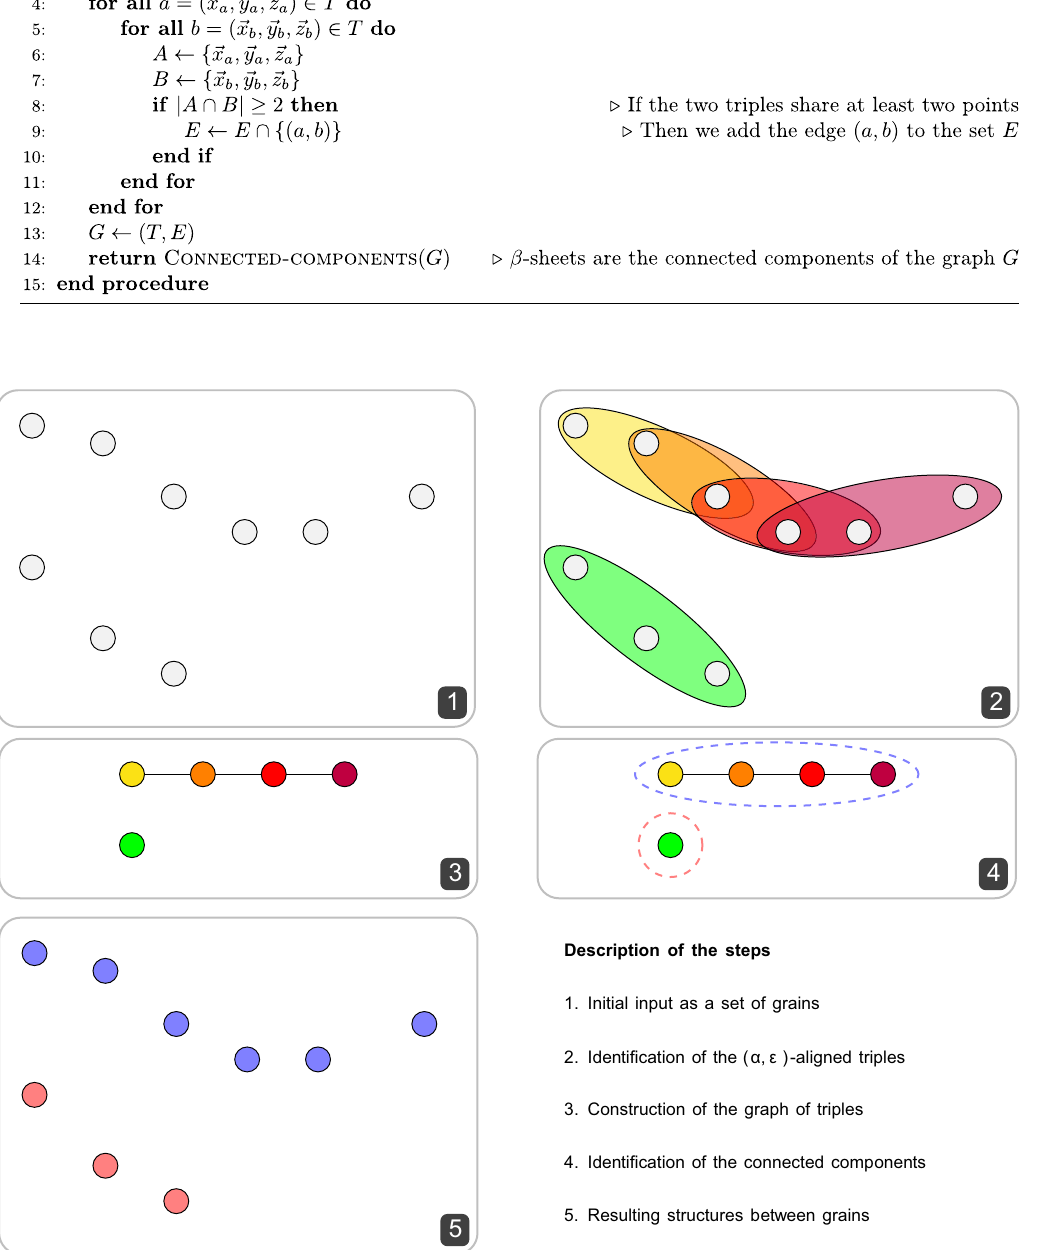
Figure 8. Main steps of the algorithm designed to recognize the presence of β